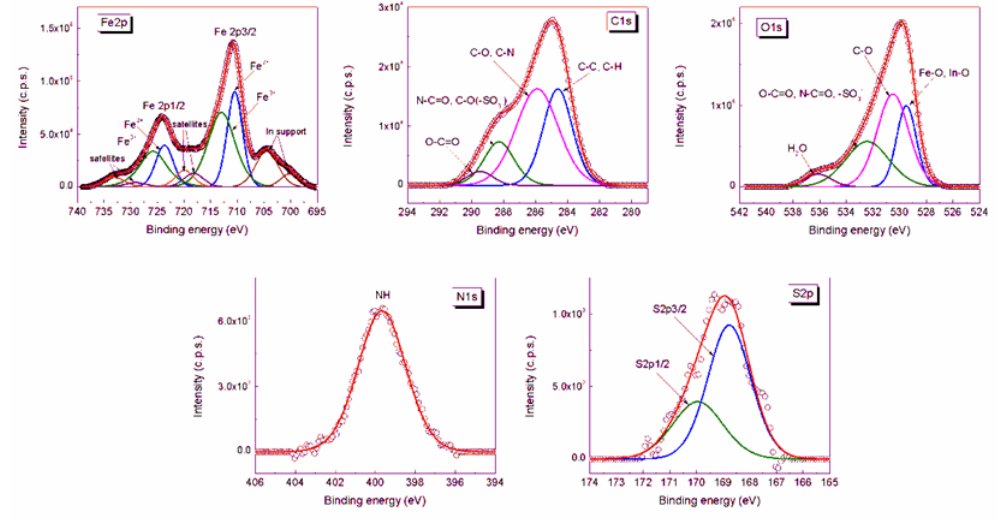
Figure 4. XPS spectra of Fe 2p, C 1s, O 1s, N 1s, and S 2p core levels from CSA@MNPs sample